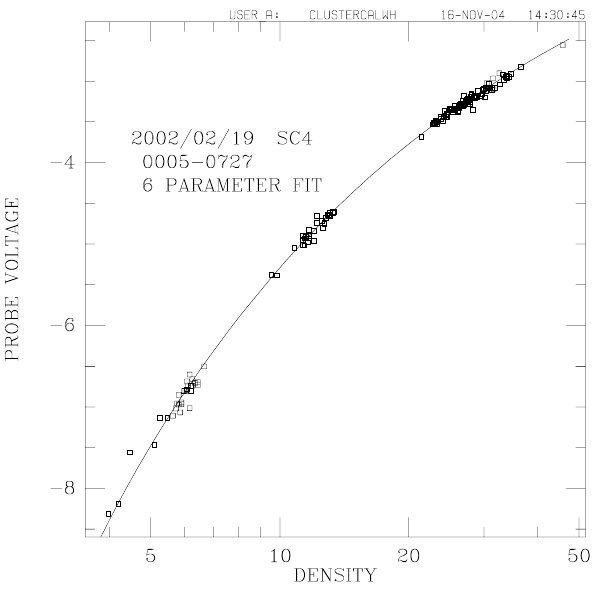
Fig. 3. Calibration of probe voltage vs. density.